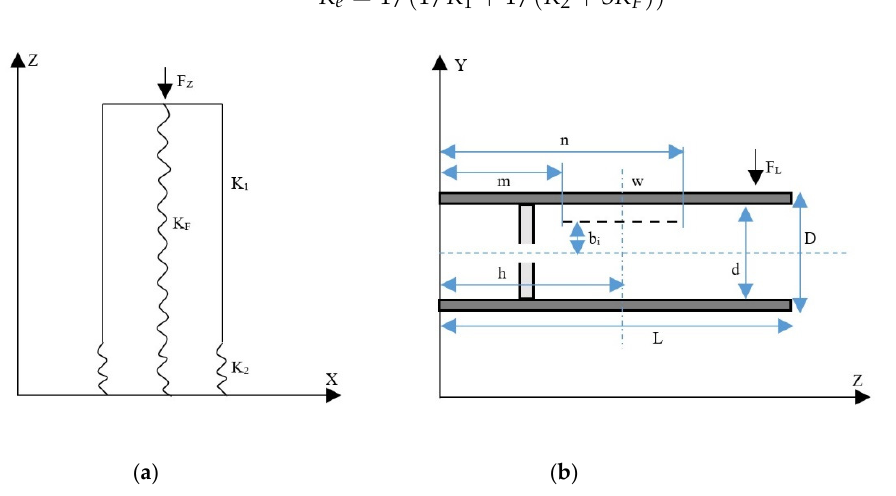
Figure 3. Equivalent models of force sensors. ( a ) Axial spring model, ( b ) transverse cantilever beam model.